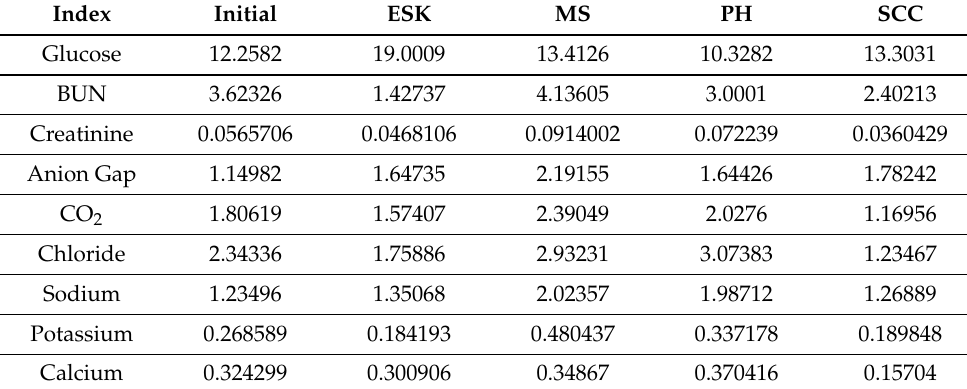
Table A2. Standard deviations in the data of the five